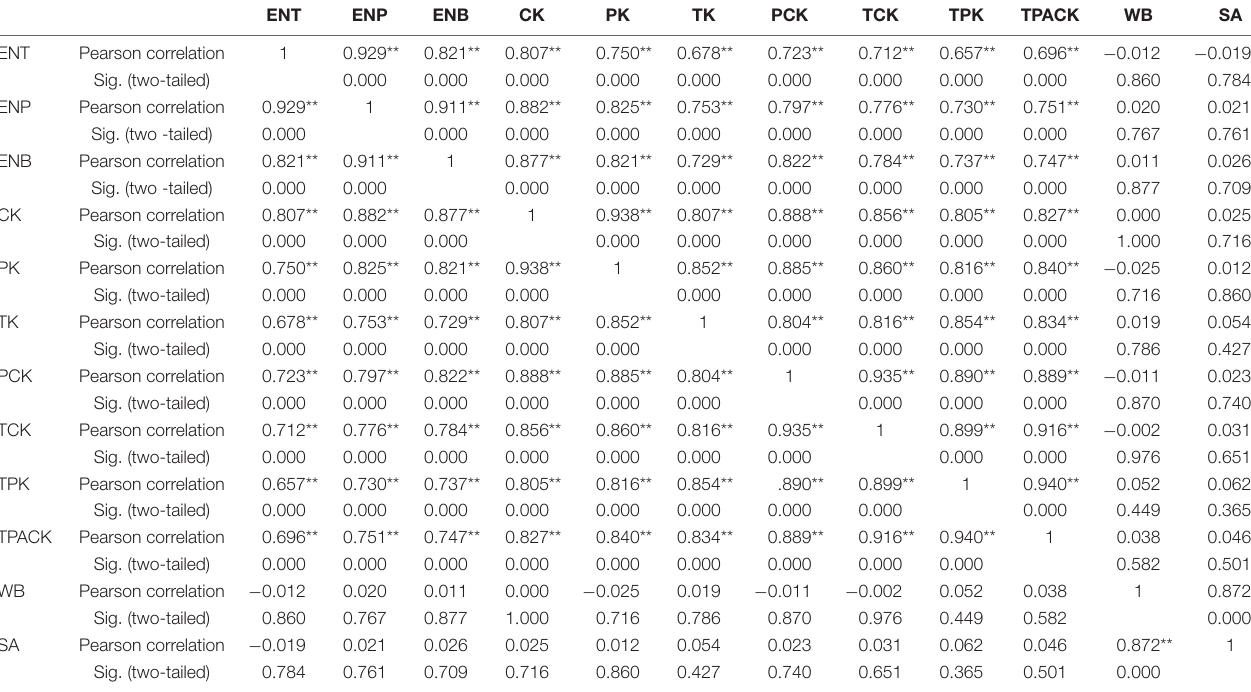
TABLE 4 | Correlations between EN, TPACK-21, and mental